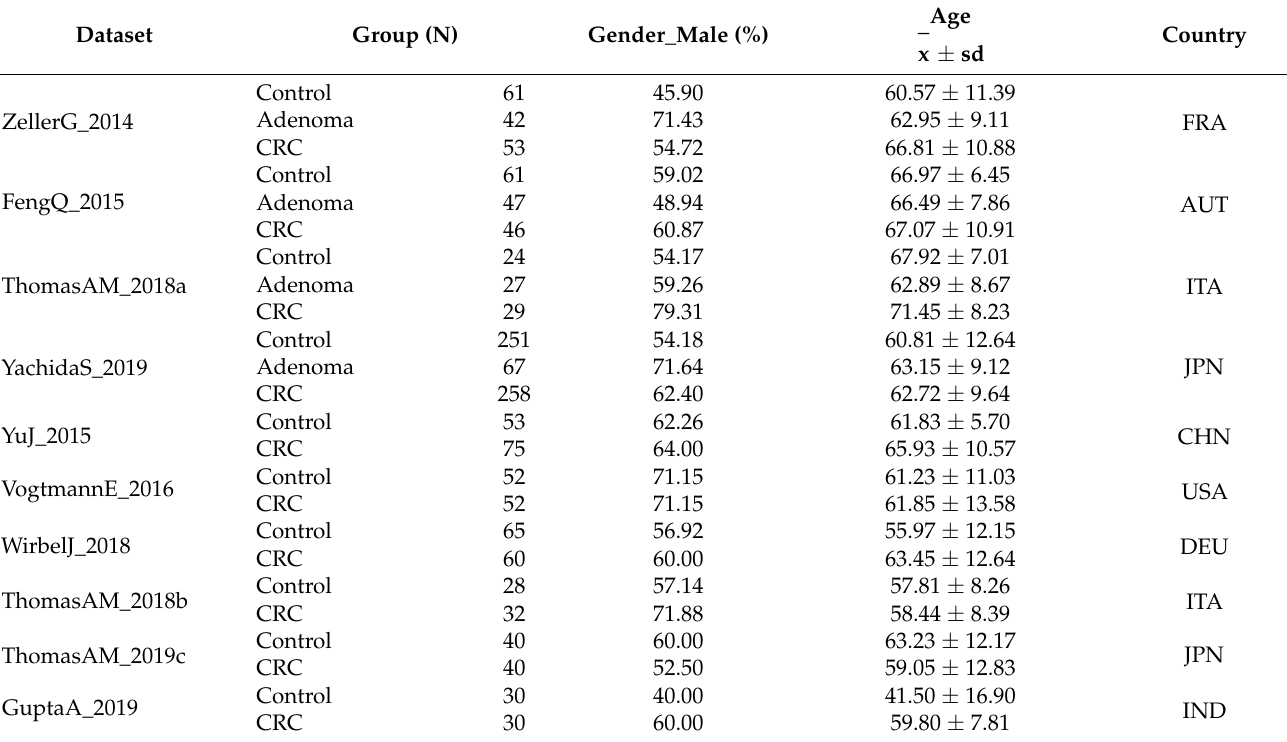
Table 2. General characteristics of the external validation